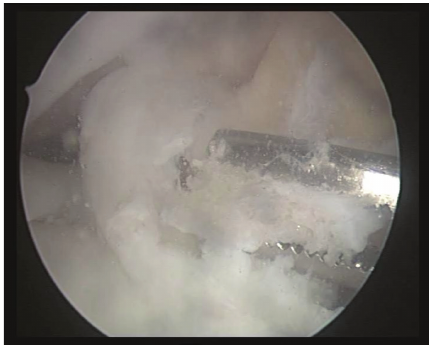
Figure 4: The intrasubstance ossicle being